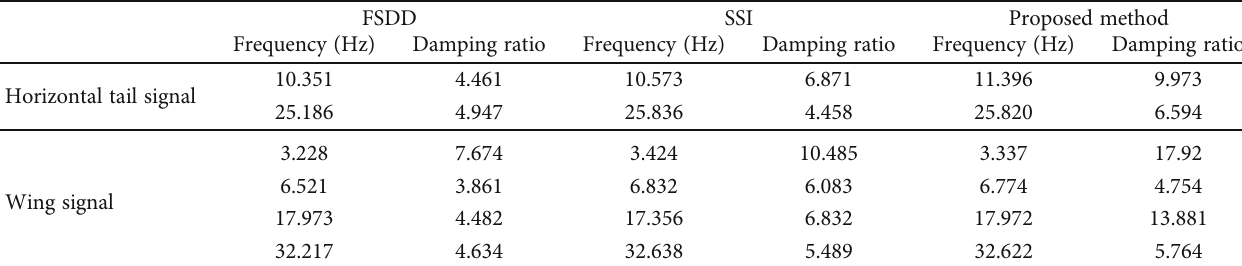
Table 3: System identi fi cation results of the physical test.